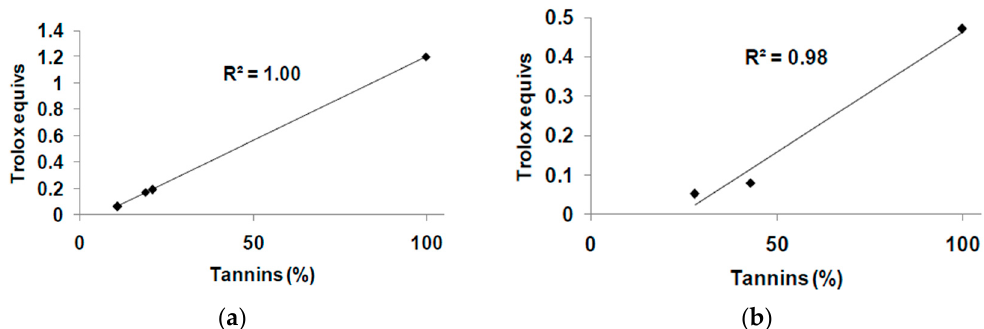
Figure 4. Correlation between tannin content and Fe 3+ -reducing activity of tannin and wood samples. ( a ) Chestnut-derived samples; ( b ) Quebracho-derived samples.